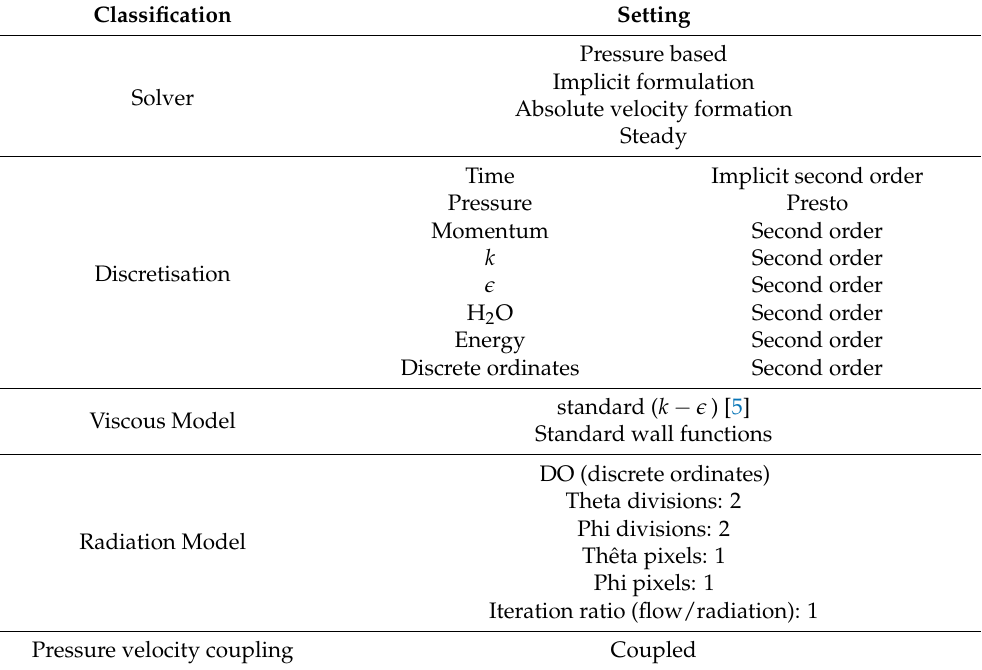
Table 1. CFD simulation Settings. Classification